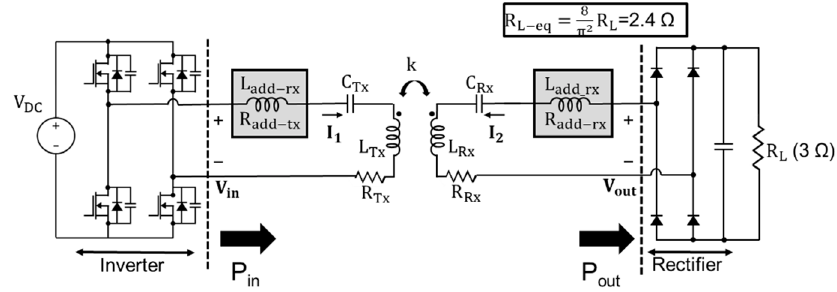
Figure 18. Circuit simulation setup for current harmonic component analysis according to L add .